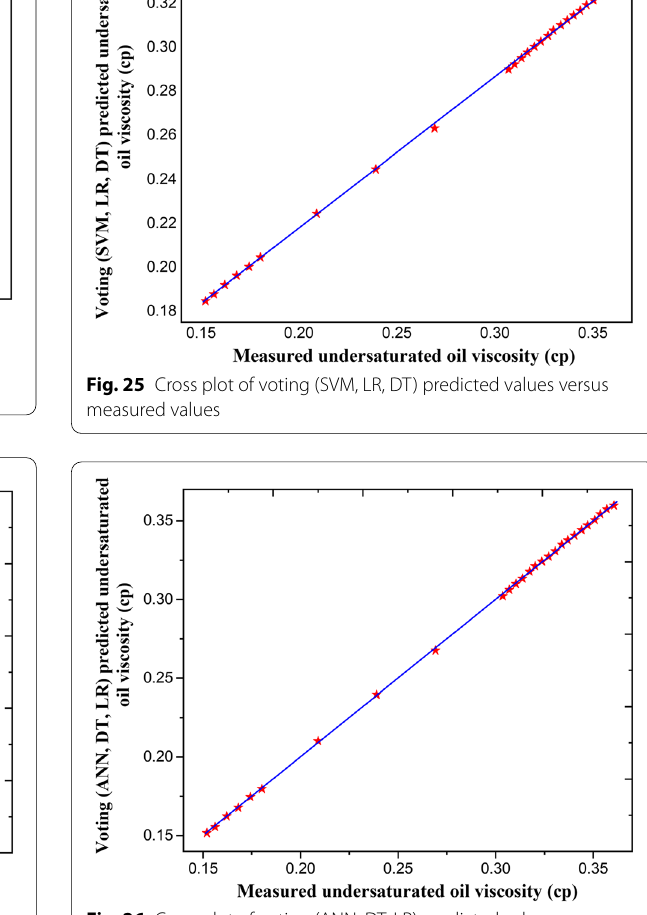
Fig. 23 Cross plot of voting (ANN, SVM, DT) predicted values versus measured values